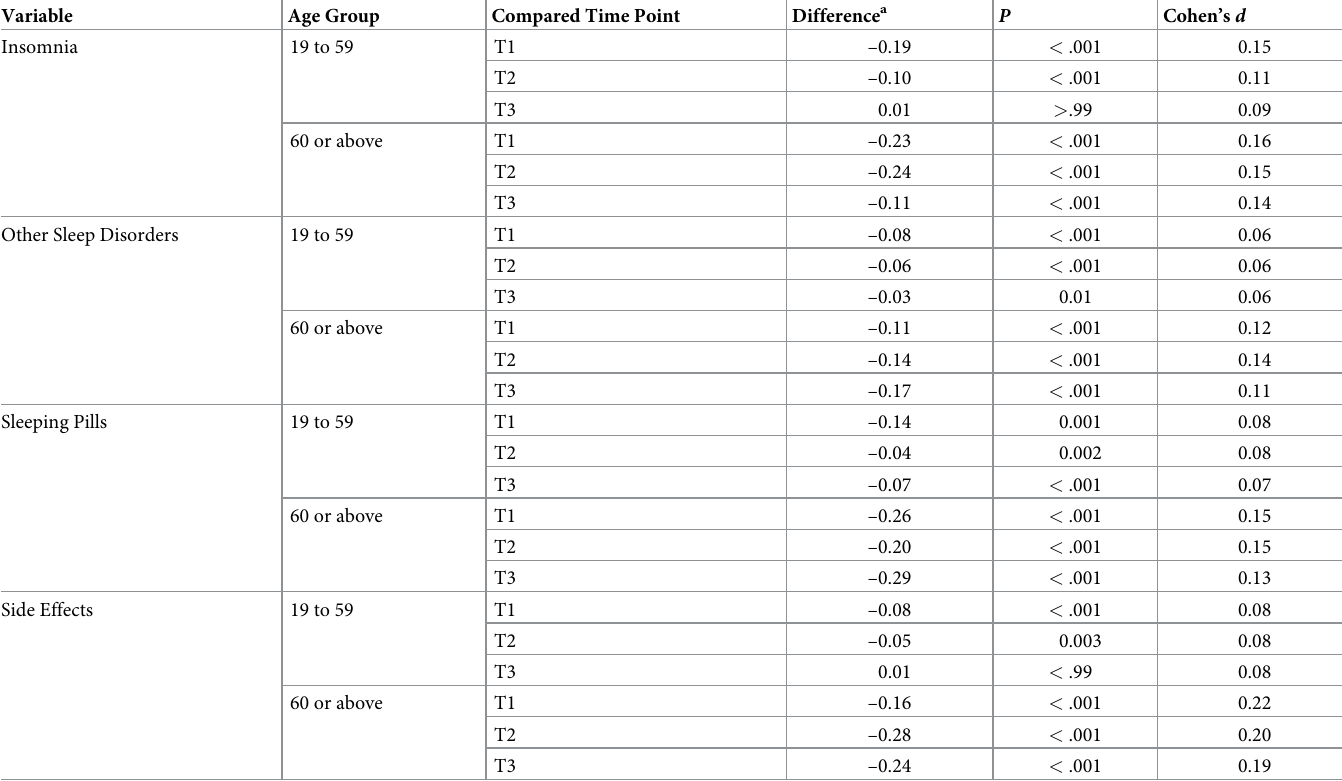
Table 2. Difference of RSV data between post-COVID-19 and pre-COVID-19 for each